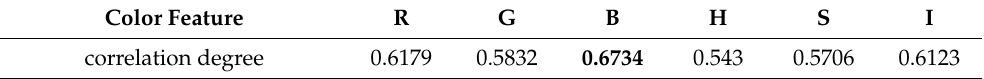
Table 2. Results of